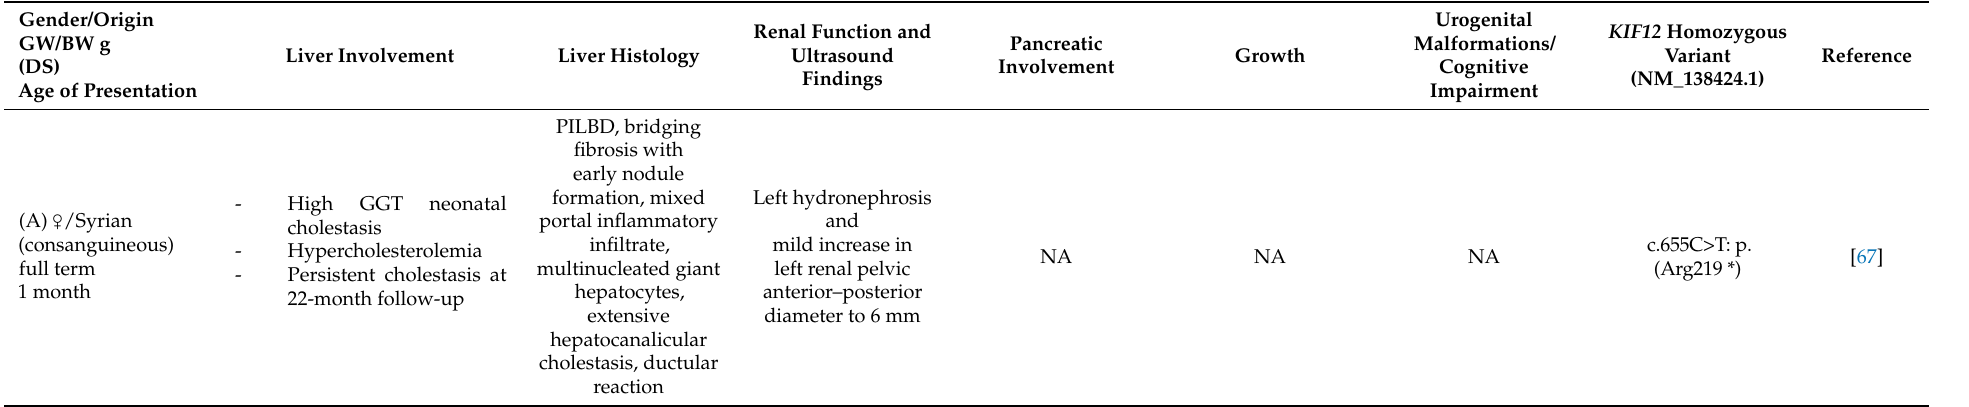
Table 3. Clinical and histopathological features of patients with KIF12 variants presenting with neonatal